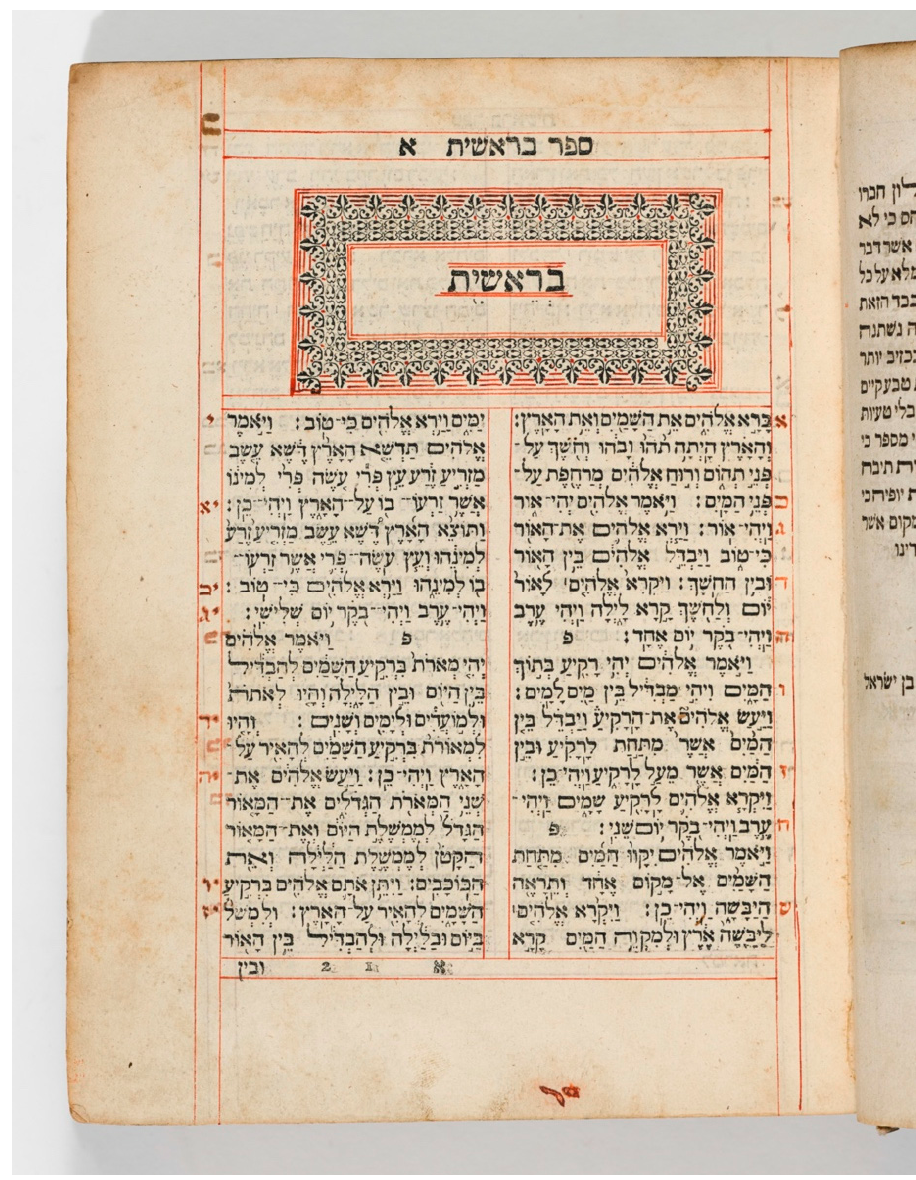
Figure 4. Tanakh (Hebrew Bible); Marsh’s Library B.3.3.13.